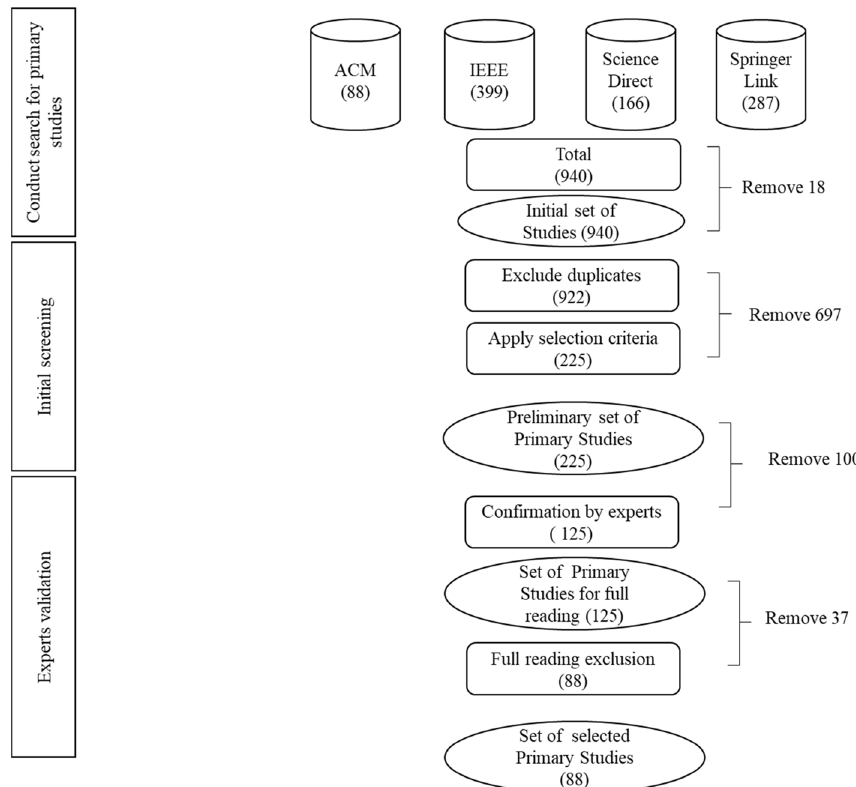
Fig. 8 Detail of the selection of primary studies during the screening of the papers